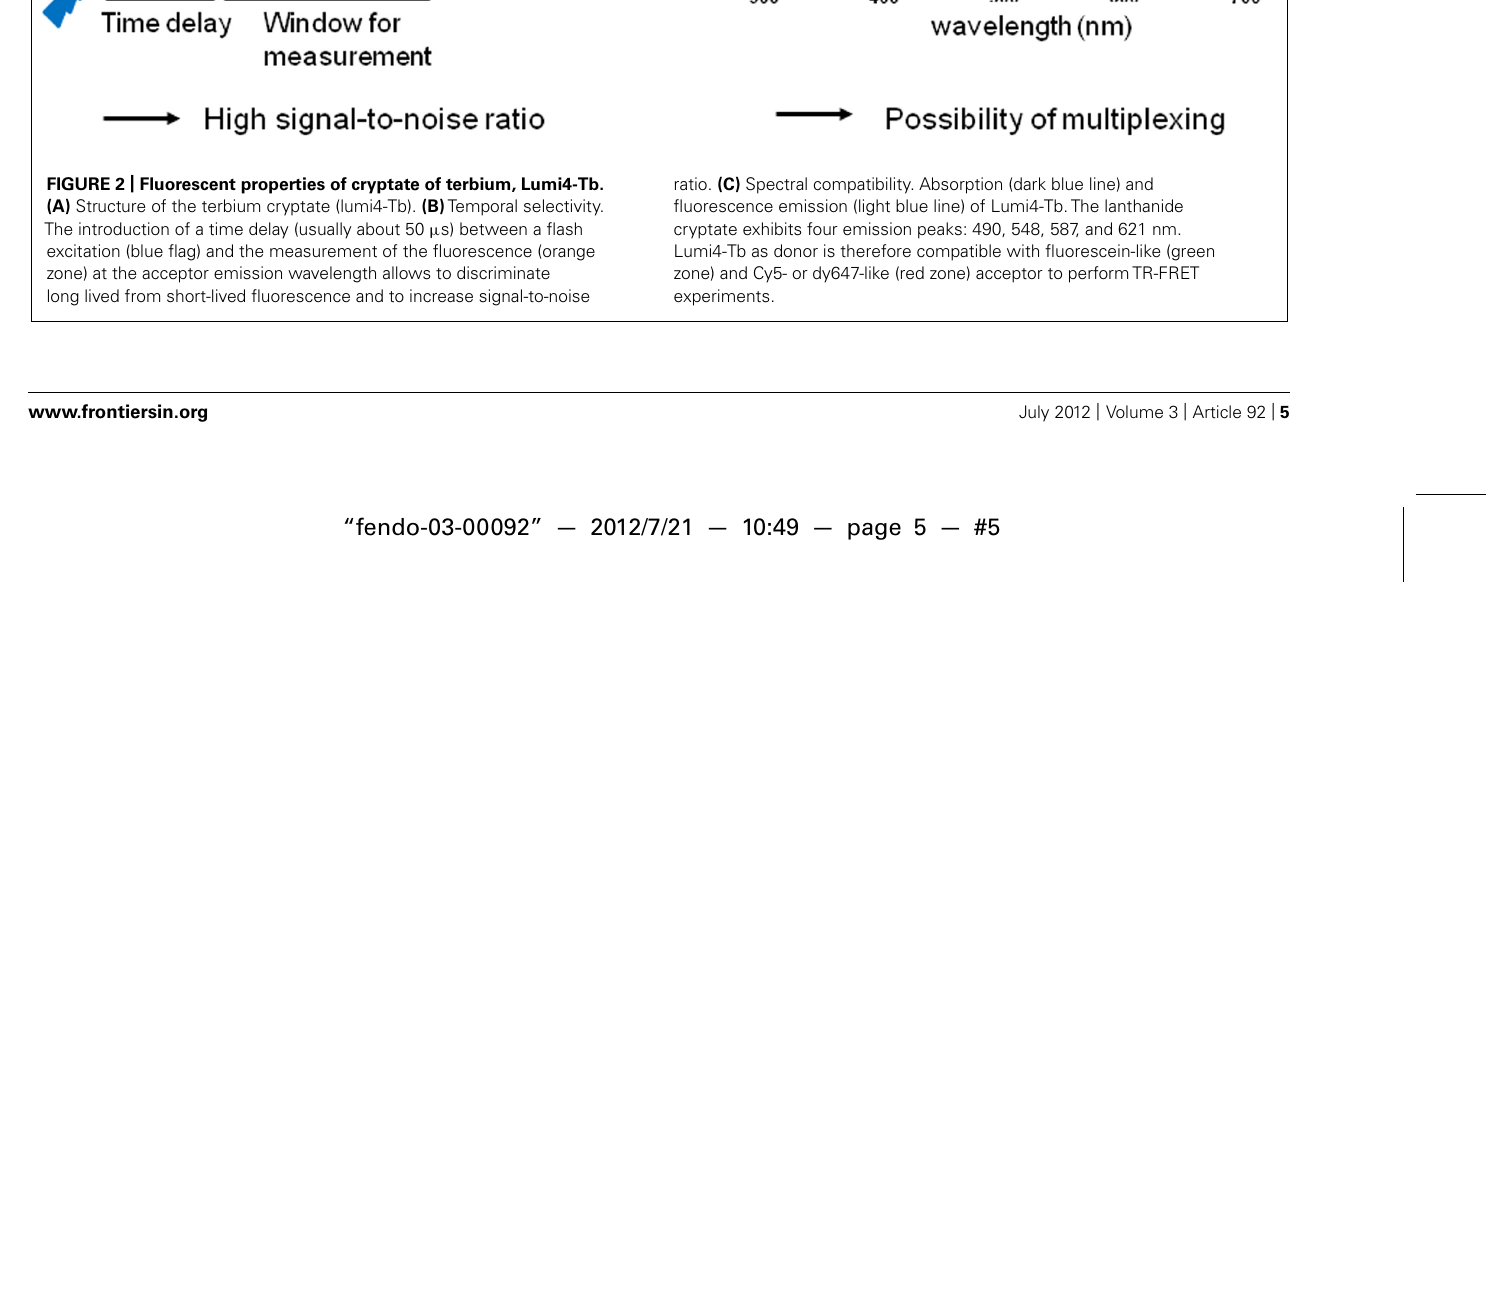
ratio. (C) Spectral compatibility. Absorption (dark blue line) and fluorescence emission (light blue line) of Lumi4-Tb.The lanthanide cryptate exhibits four emission peaks: 490, 548, 587, and 621 nm. Lumi4-Tb as donor is therefore compatible with fluorescein-like (green zone) and Cy5- or dy647-like (red zone) acceptor to performTR-FRET